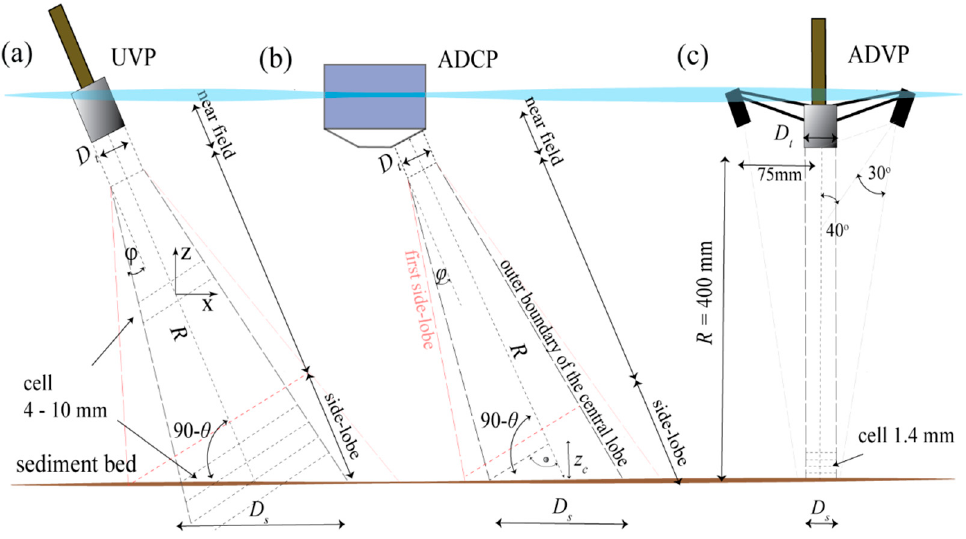
Acoustic Figure 2. Acoustic geometry. ( a ) Acoustic Doppler velocity profilers (ADVPs)—Ubertone; ( b ) UVP— Ubertone; ( c ) ADCP Stream Pro—RDI.